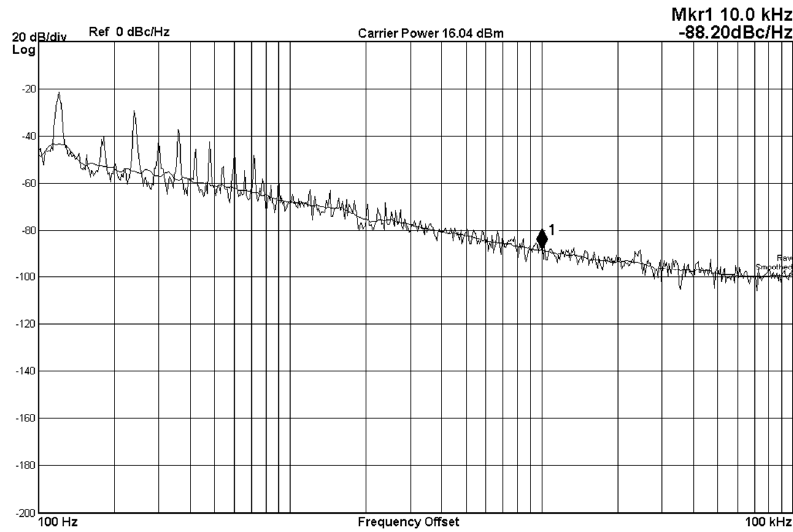
Figure 21. The measured phase noise of the proposed oscillator of V o 1 .